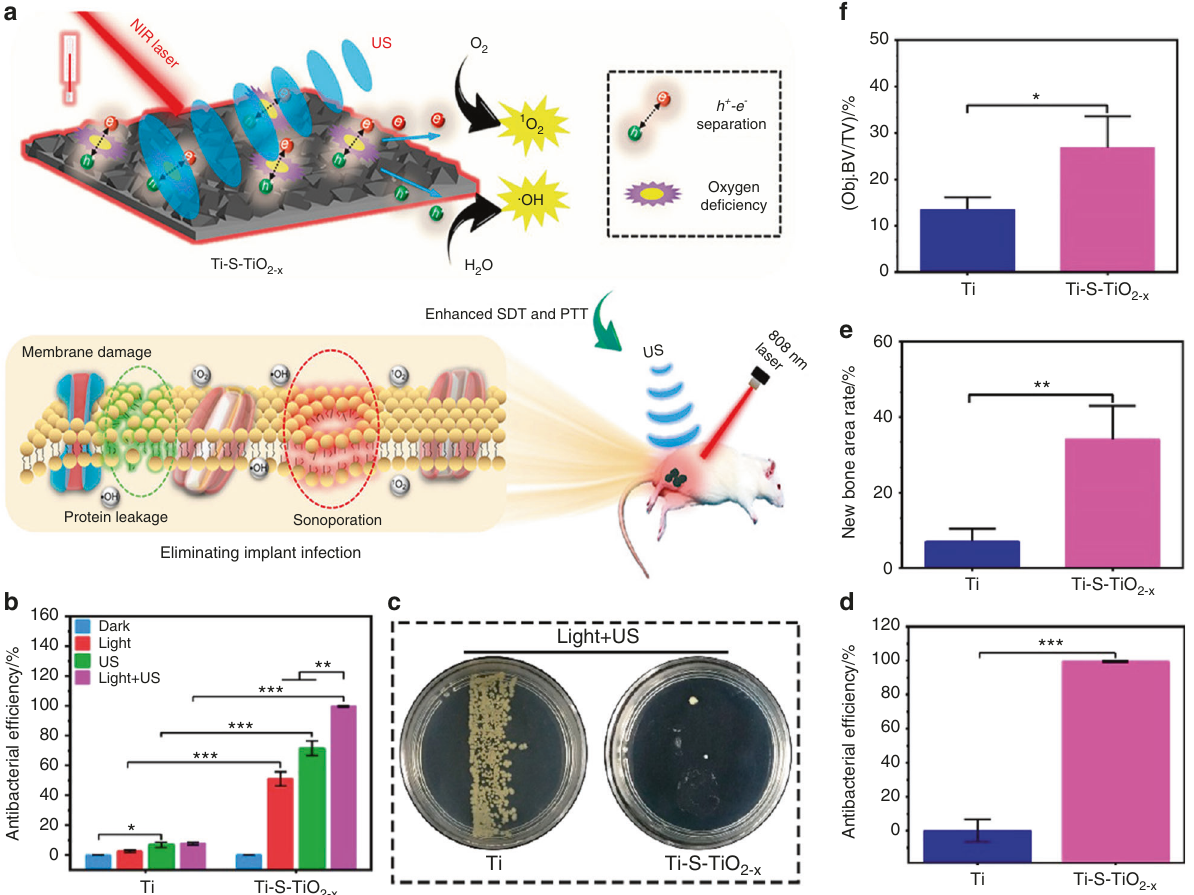
Fig. 6 Rapid photo-sonotherapy for clinical treatment of bacterial infected bone implants by creating oxygen de fi ciency using sulfur doping. a Scheme of the fabrication of sulfur-doped om titanium implant (Ti-S-TiO 2 – x ), which can enhance sonocatalytic-photothermal ability and manifest exhibits ef fi cient bone infection therapy. b In vitro antibacterial ef fi ciency of 2 kinds of titanium implant in four different conditions for S. aureus from spread plate. c Bacteria colony images to reveal the in vivo antibacterial performance. d The results of the spread plate to reveal the in vivo antibacterial ef fi ciency. e Corresponding calculated new bone area to reveal the in vivo osteogenic performance. f The results of bone volume/total volume (BV/TV) based on the micro-CT results (* P < 0.05, ** P < 0.01, *** P < 0.001). Reproduced